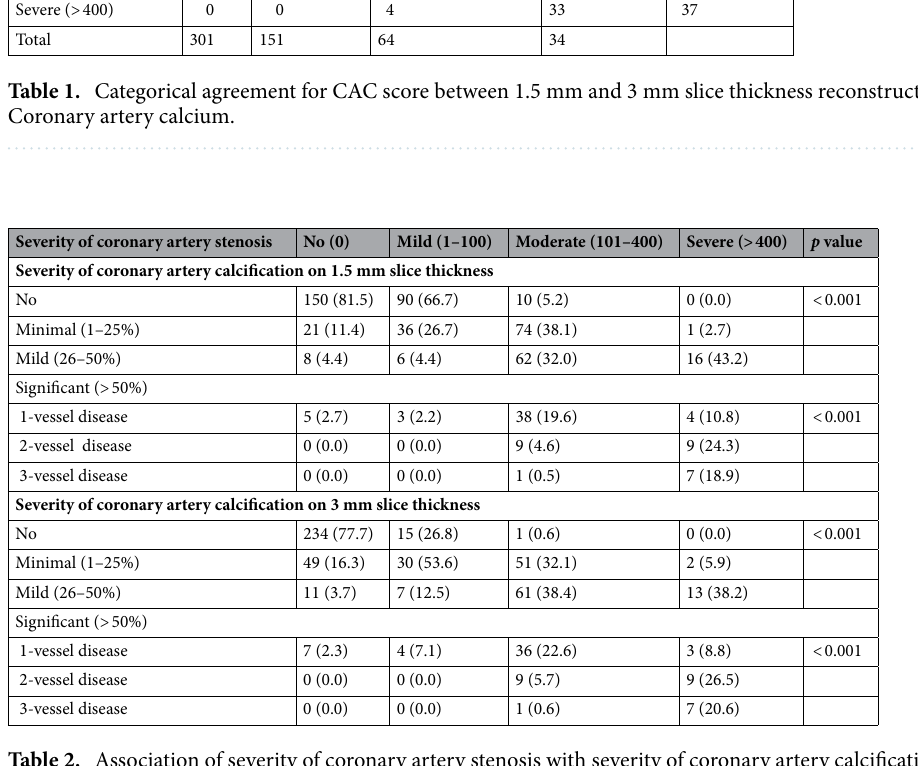
Table 2. Association of severity of coronary artery stenosis with severity of coronary artery calcification. Data expressed as number of individuals